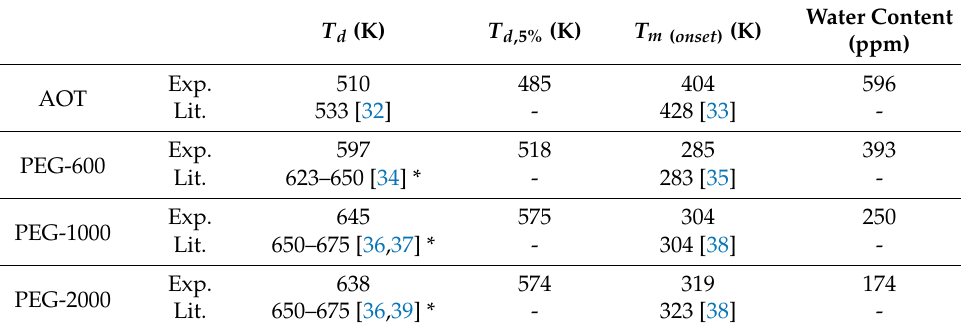
Table 2. Water content and thermal characterization of pure compounds.